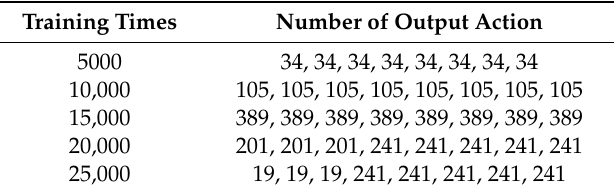
Table 6. Decision Optimization Results.